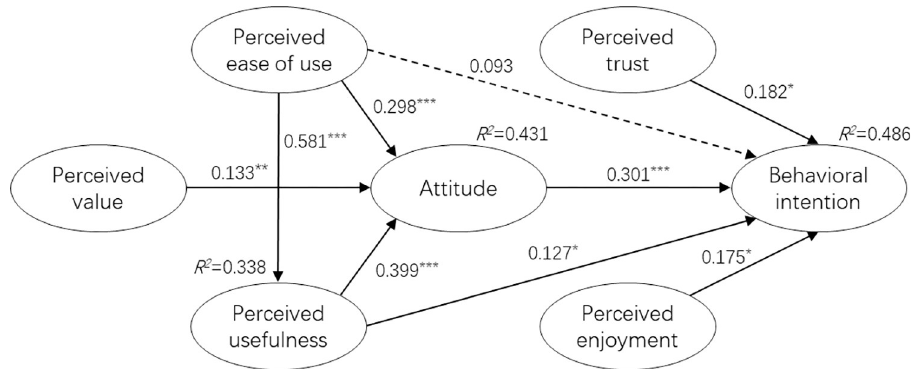
Fig 2. Verification results. Note: � :p < 0.05; �� : p < 0.01; ��� : p < 0.001.